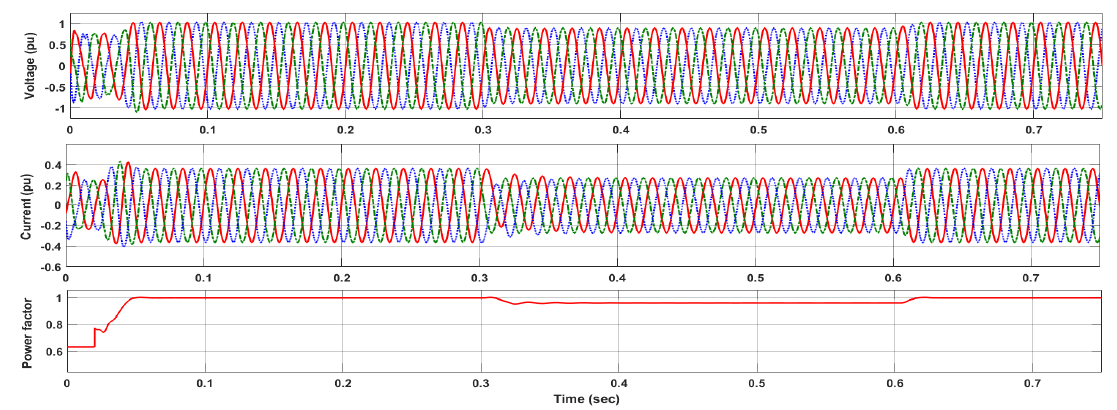
FIG. 11. REAL TIME VOLTAGE, CURRENT, AND POWER FACTOR PLOTS WITH SVC